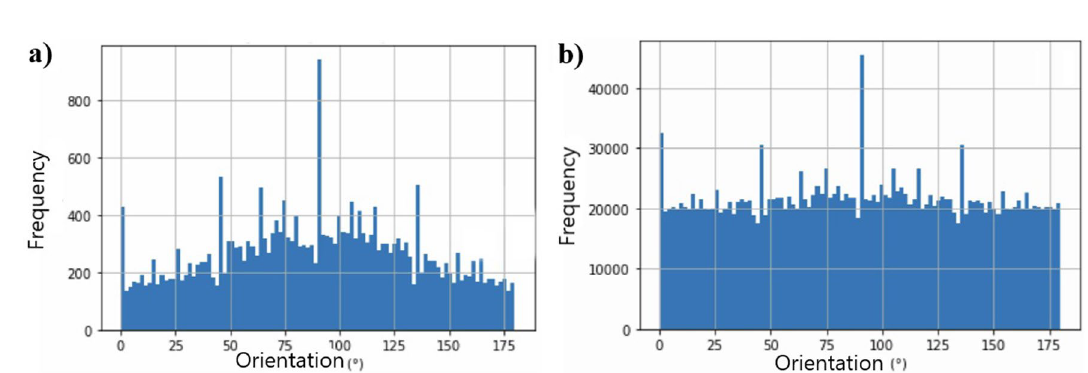
Figure 20. Accumulated pore frequency depending on the area ( a ) before degradation and ( b ) after degradation.